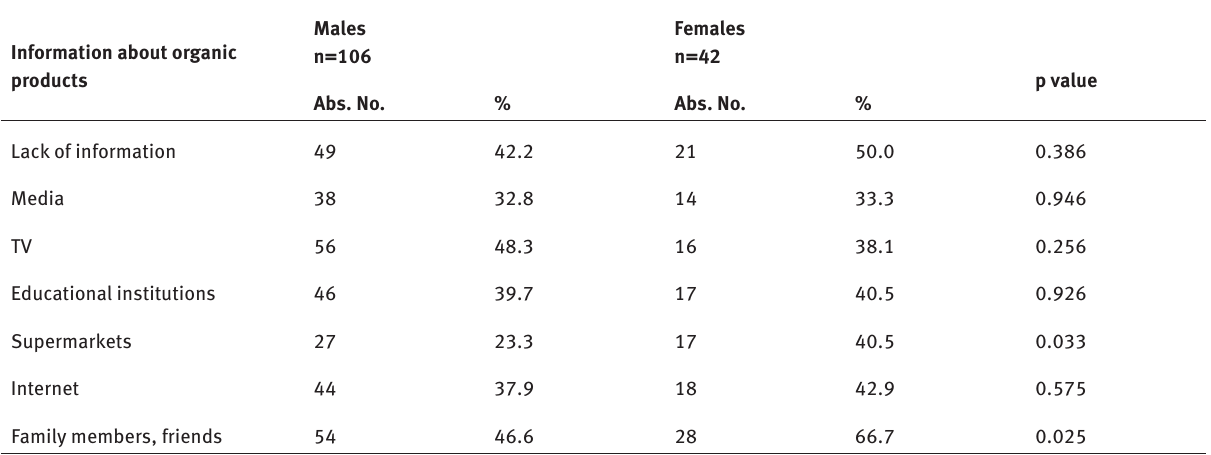
Table 4: Accessibility of information about organic products by gender